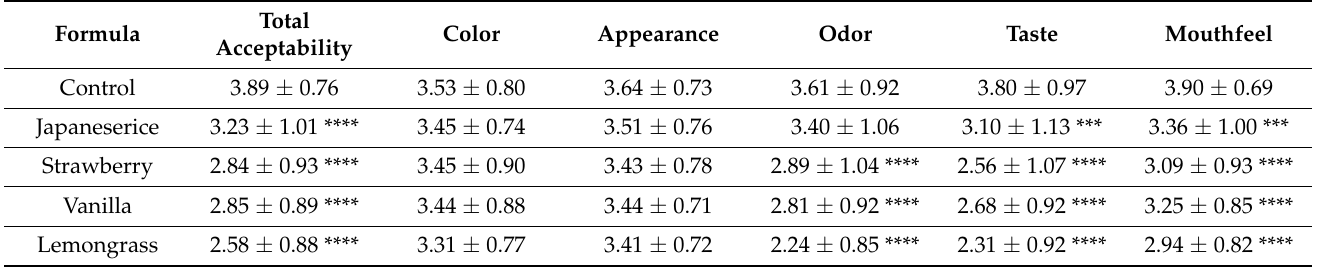
Table 5. Sensory satisfaction scores for the control and various flavor-fortified formulas.